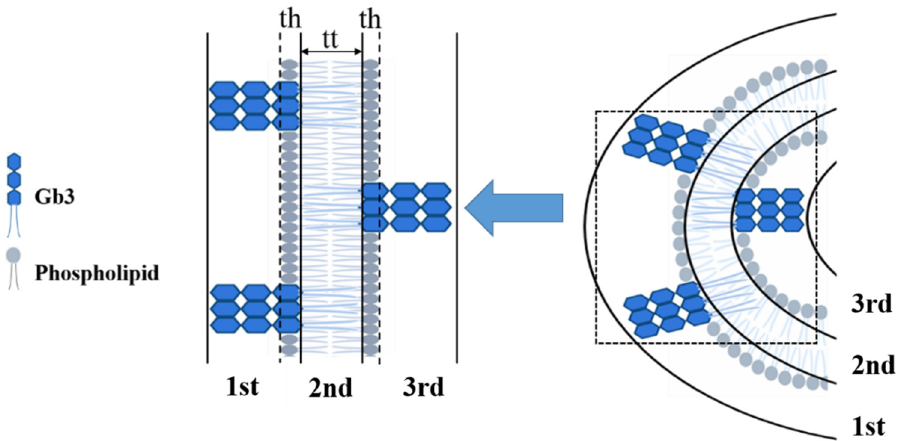
Figure 4. Schematic picture of SUV model adopted for the three-shell model fitting. Each shell contains the following constituents. First and third shells, combination of the protruding oligosaccharide chains, the DPPC choline head, and the rest of the oligosaccharide chains; second shell, hydrocarbon chains of DPPC and Gb3. t h is the thickness of hydrophilic phospholipid headgroup; t t is the thickness of the inner part of the vesicle, consisting of the hydrophobic tails of both phospholipid and Gb3.